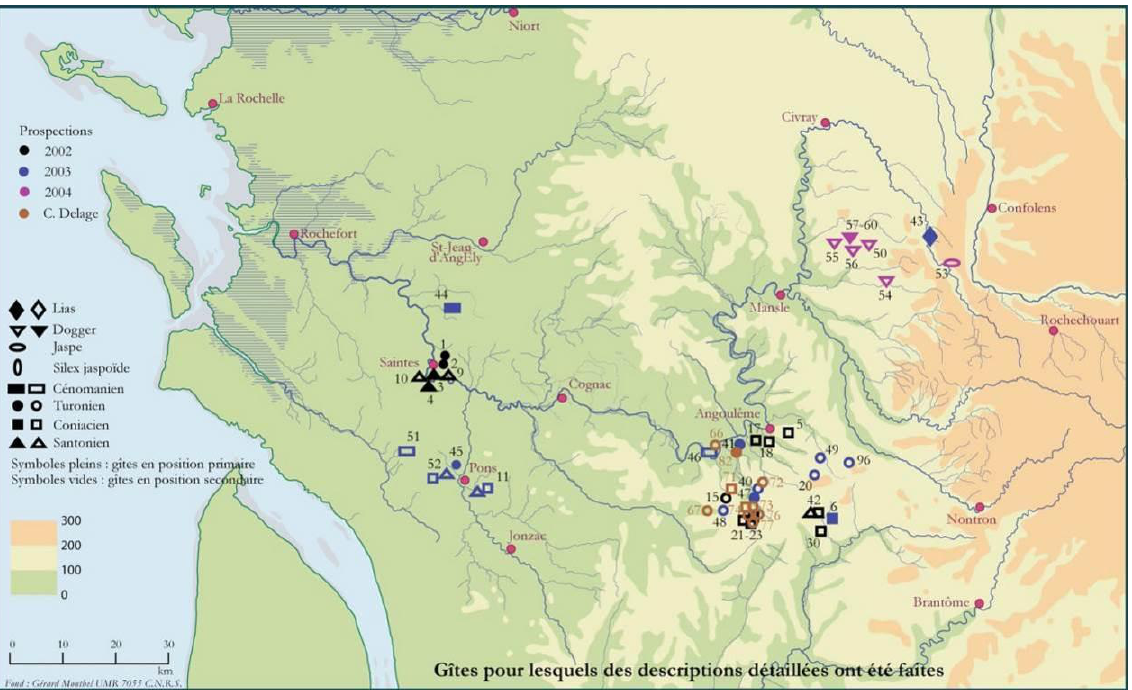
Figure 7. Geological map of the Charente Basin and the surveys conducted. Source: Féblot-Augustins & Parks